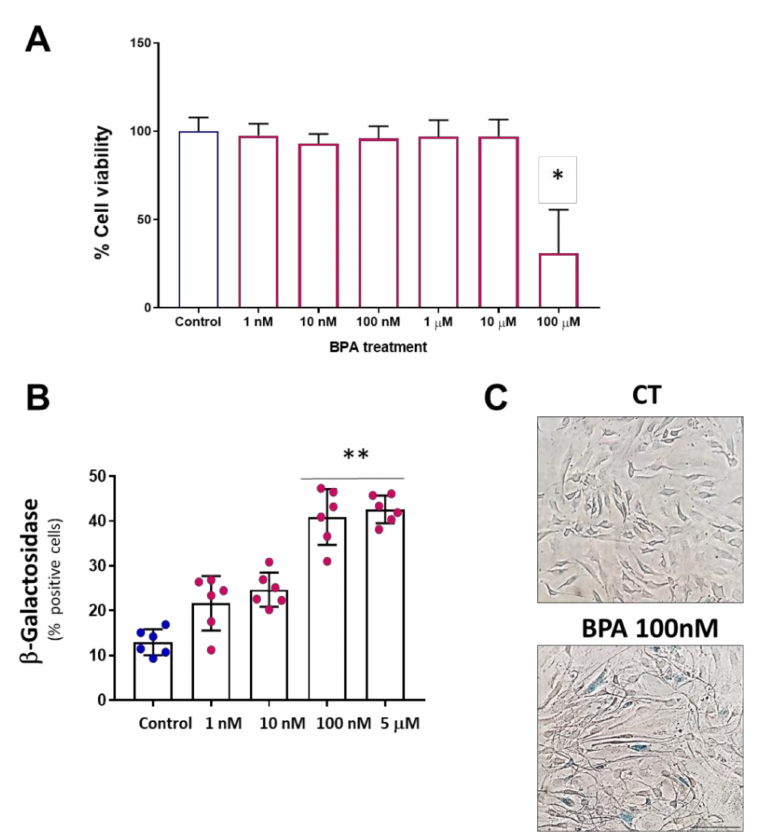
Figure 1. BPA induces cellular senescence at low concentrations. ( A ) MTT viability assay in MAEC treated with BPA 5 days at concentrations ranging from 1nM to 100 µ M. A significant reduction in cell viability is observed at 100 µ M. Data are the means ± SD (n = 3 with a triplicate per experimental condition). p was determined by a Kruskal–Wallis test with Dunn’s multiple comparisons test. * p < 0.0001. ( B ) Senescence-associated β -Gal assay in MAEC treated with BPA 5 days at the indicated concentrations. Note that the maximum effect on cell senescence was observed at concentrations of 100 nM and 5 µ M. Data points represent the mean ± SD (n = 6 in triplicate). p was determined by a Kruskal–Wallis test with Dunn’s multiple comparisons test. ** p < 0.001 ( C ). Representative microphotographs of the senescence assay (scale bar = 50 µ m). Senescent cells show the characteristic staining of β -Gal in blue color, CT means control